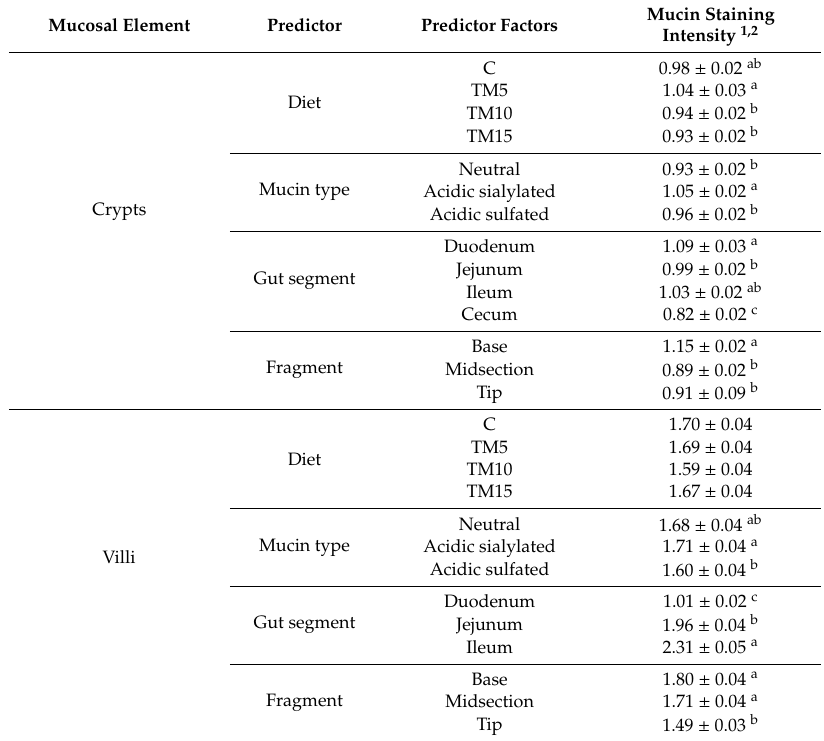
Table 2. Mucin staining intensity in the intestinal crypts and villi of the heavy-size broiler chickens according to the specific predictor factors (diet, mucin type, gut segment and